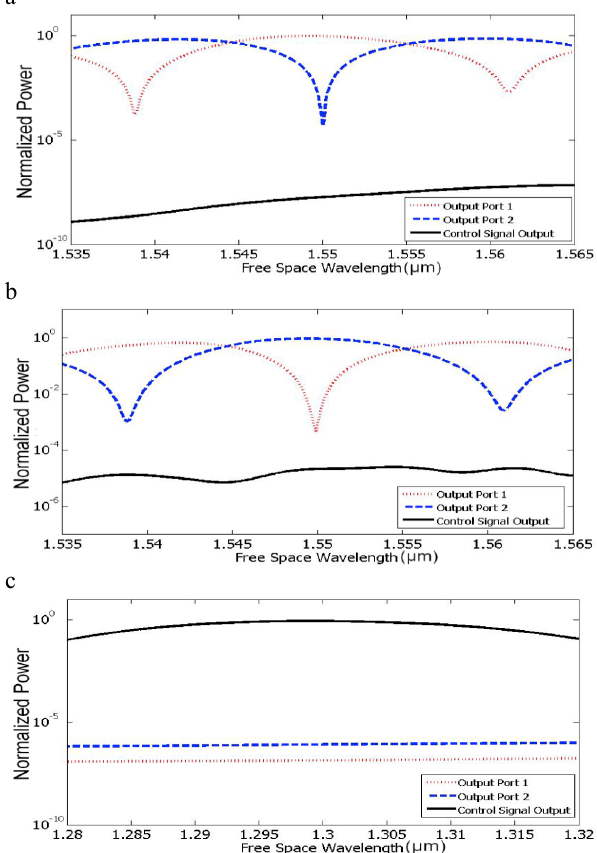
Figure 8: Transmitted power to the output ports of the PhC directional coupler for (a) the linear case, (b) the nonlinear case around 1.55 µ m and (c) the nonlinear case around 1.3 µ